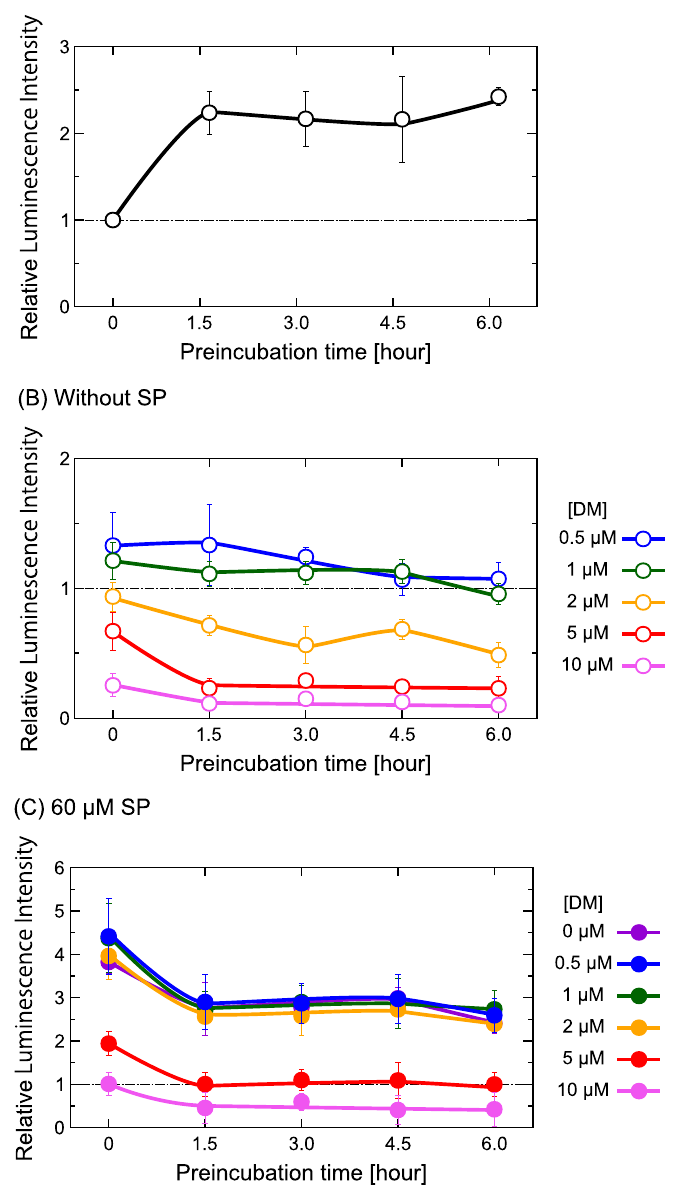
Figure 2. Effects of daunomycin (DM) on gene expression. Results with the same incubation period of 1.5 h at 30 °C after different preincubation periods at 0 °C are shown. The horizontal axis indicates the period of preincubation at 0 °C. ( A ) Control experiment in the absence of both spermine (SP) and DM. The intensity was normalized to the control (=1.0), as indicated at the left-end circle, where SP and DM were absent without preincubation time at 0 °C. ( B ) Gene expression for various con- centrations of DM in the absence of SP. ( C ) Gene expression for various concentrations of DM in the presence of 60 µM SP. The relative luminescence intensity in ( B , C ) are each normalized (=1.0) with the relative luminescence intensity from ( A ) for the same incubation period. The DNA concentration was fixed at 0.6 µM in nucleotide unit. The error bars show the standard deviation.